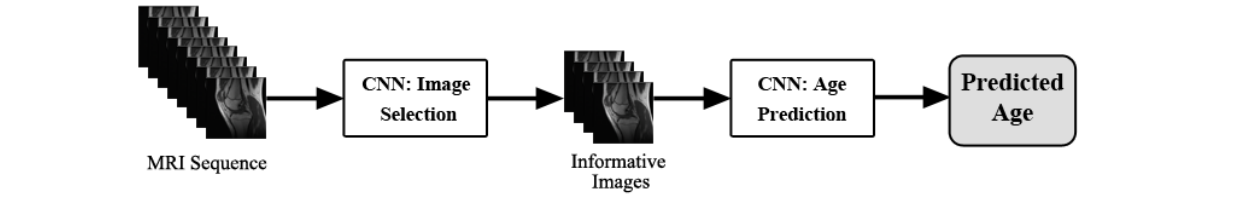
Figure 1. Overview of the proposed automated age-assessment method. CNN: convolutional neural network; MRI: magnetic resonance imaging.